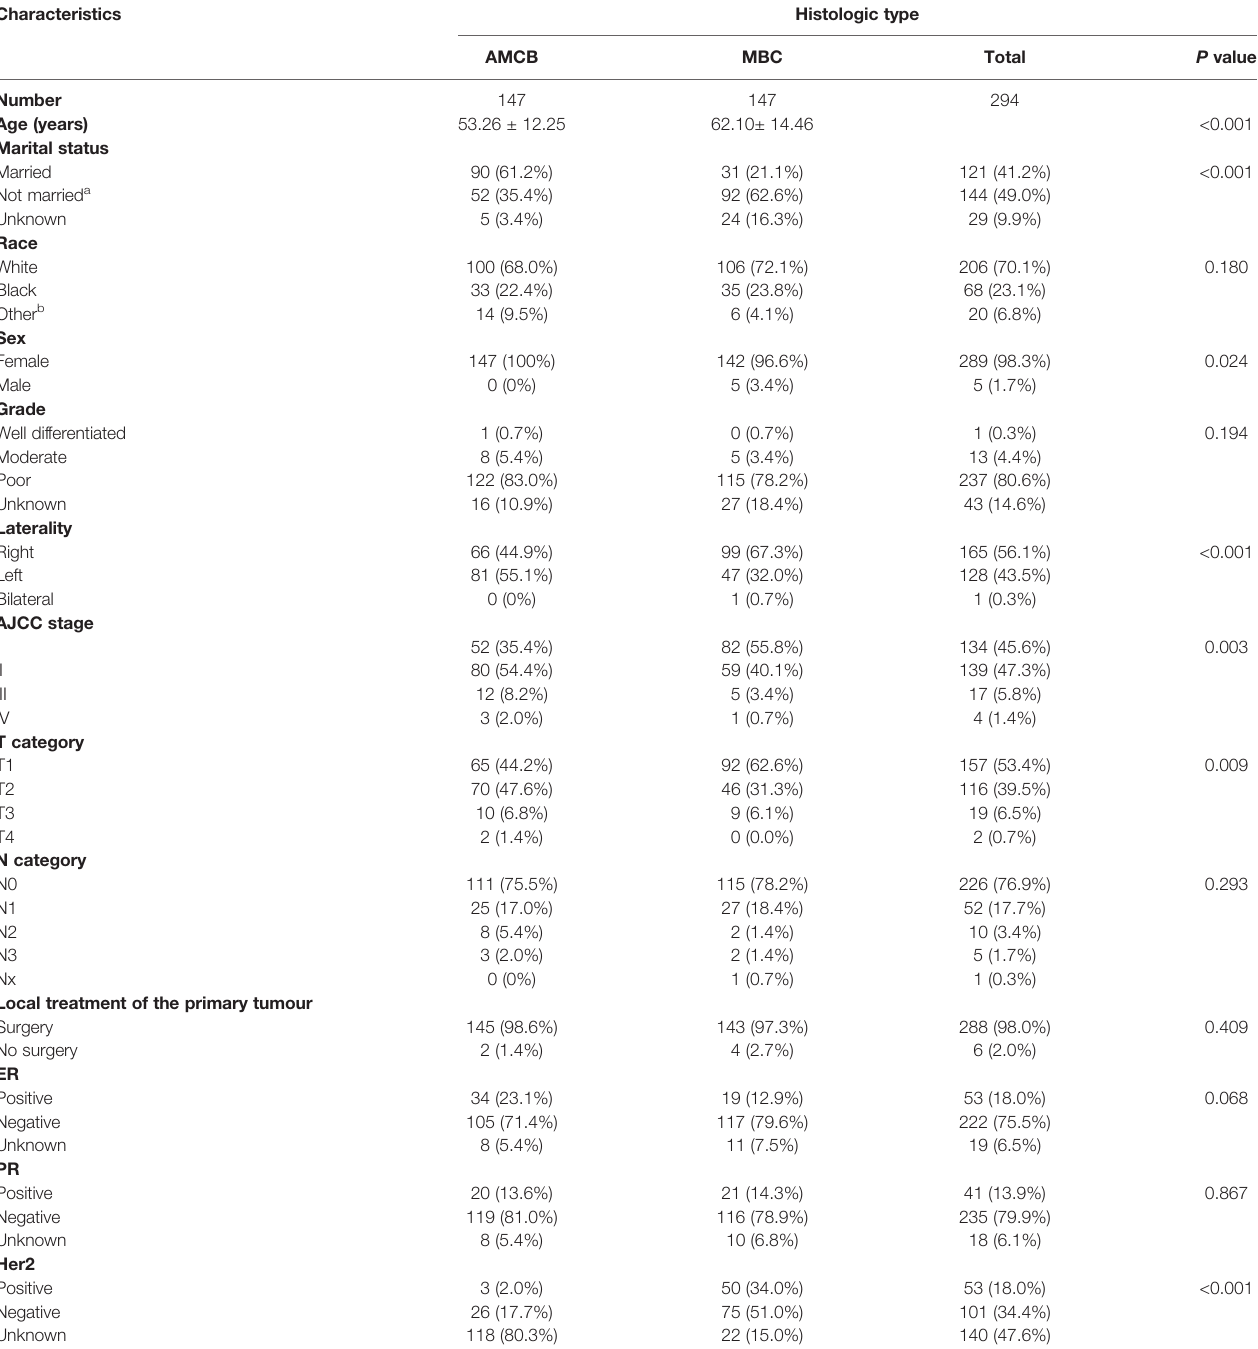
TABLE 3 | Patient characteristics with histologic type of breast cancer after propensity score matching in the SEER database, 2004 –